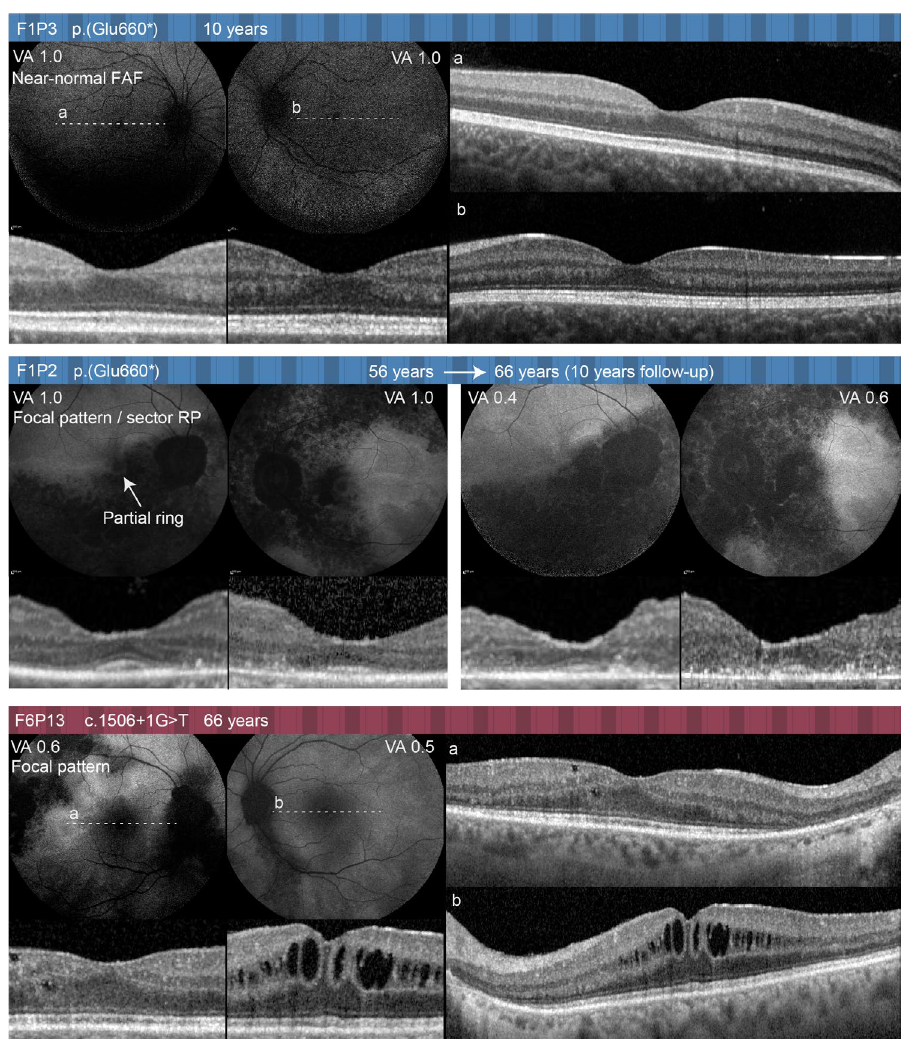
Figure 9. FAF and central OCT of females from families 1 and 6. Dashed lines show the location of the wider OCT scan shown on the right ( a , b ). Follow-up images are shown for patient F1P2 who presented deterioration of the photoreceptor structure in the fovea with time.